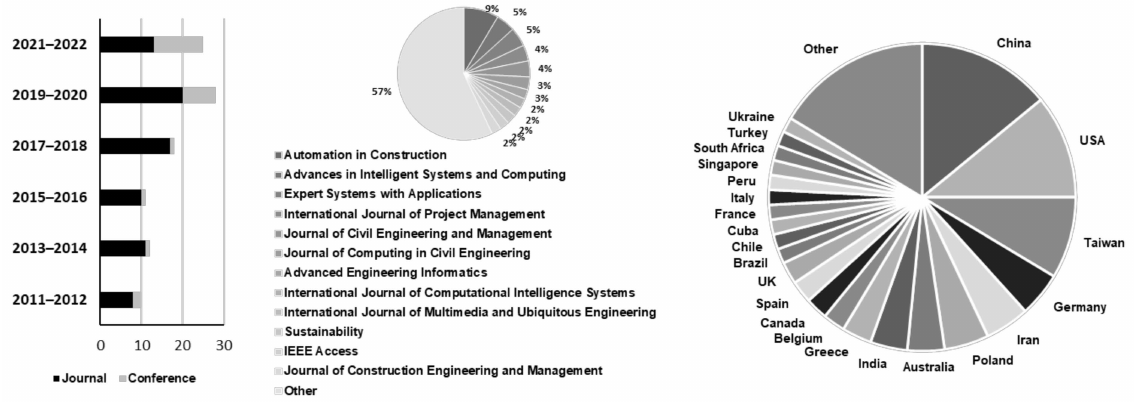
Figure 1. Bibliometric results. Temporal evolution with publication type ( left ), journals of selected papers ( middle ), and per-country distribution ( right